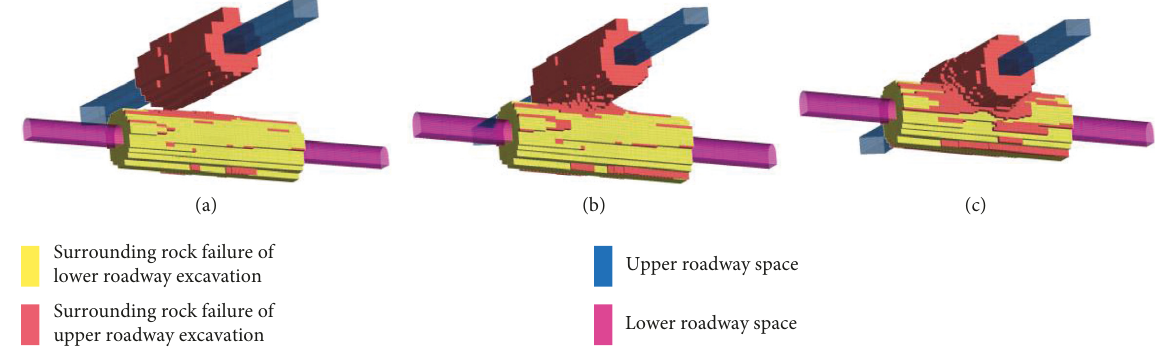
Figure 5: Disturbance influence of distance between roadways on surrounding rock failure of staggered roadway. (a) Distance between roadways 12m,(b) distance between roadways 6m, and (c) distance between roadways